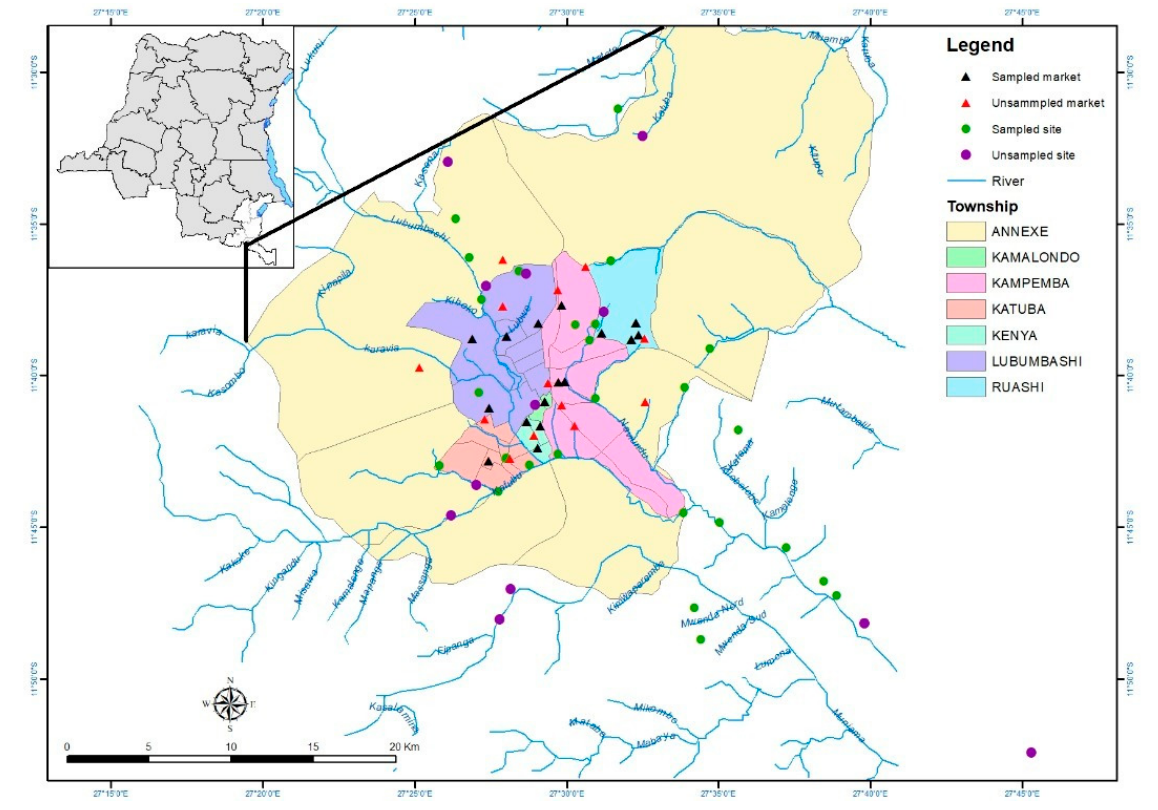
Figure 1. Map of the market gardens and urban markets of Lubumbashi (Mununga, K.F, 2022). Table 2. XRF determination of metals in 29 urban and peri-urban market gardens of Lubum- bashi